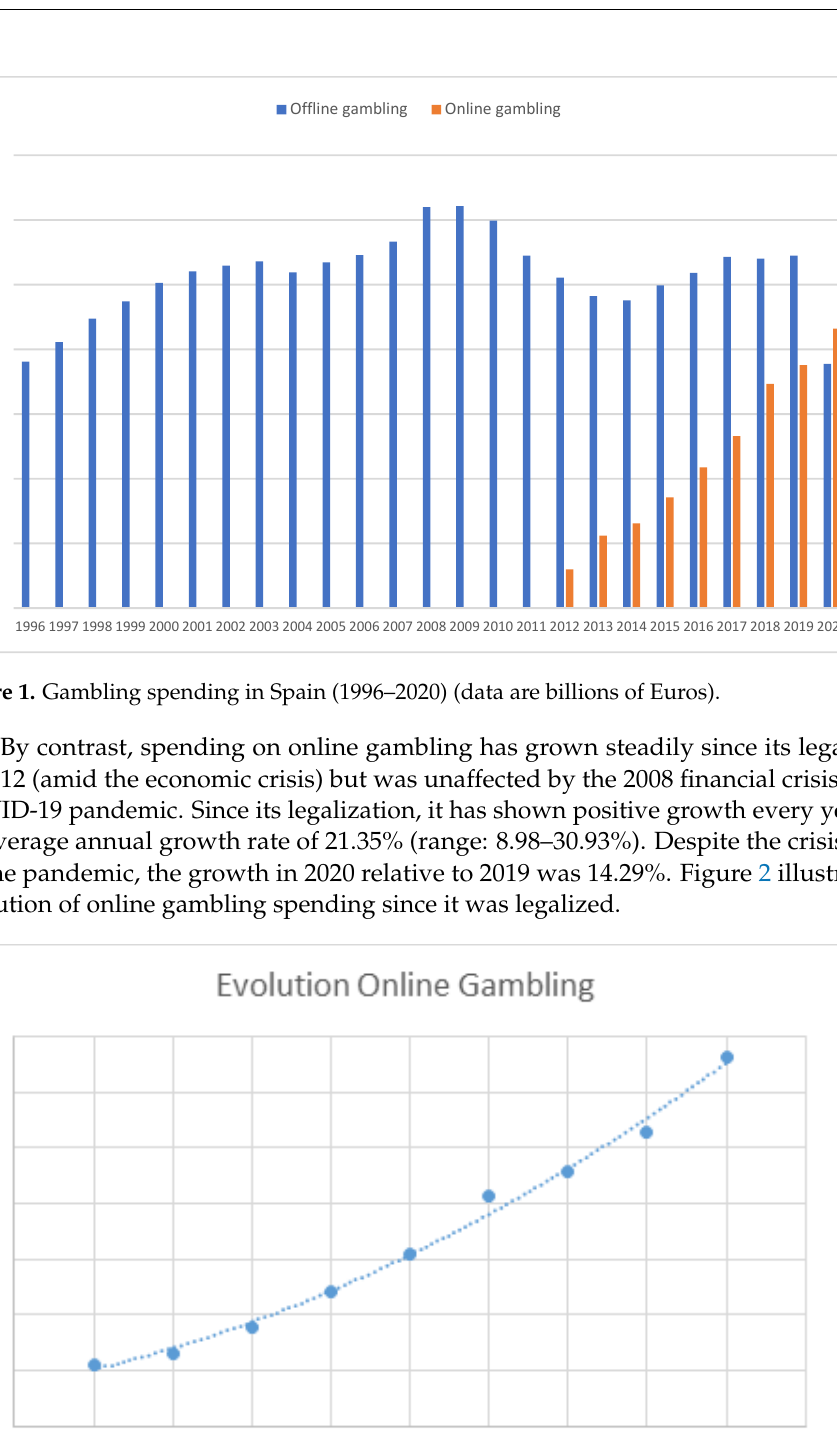
Figure 2. Evolution of online gambling (2013–2021) in Spain (data are billions of Euros).